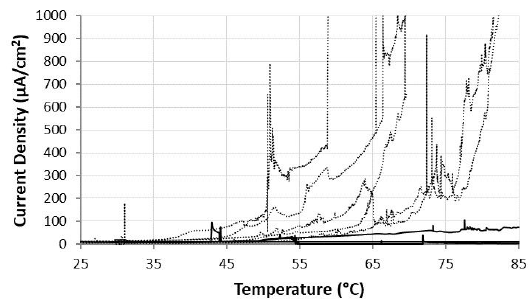
Figure 4. CPT results for the tested alloys.